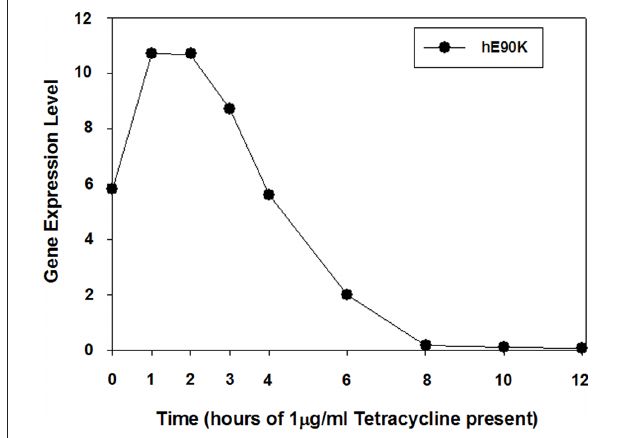
FiGurE 1 | Tetracycline inhibits accumulation of E 90 K mrNA (normalized with 18S rNA) and assessed by real-time PCr.